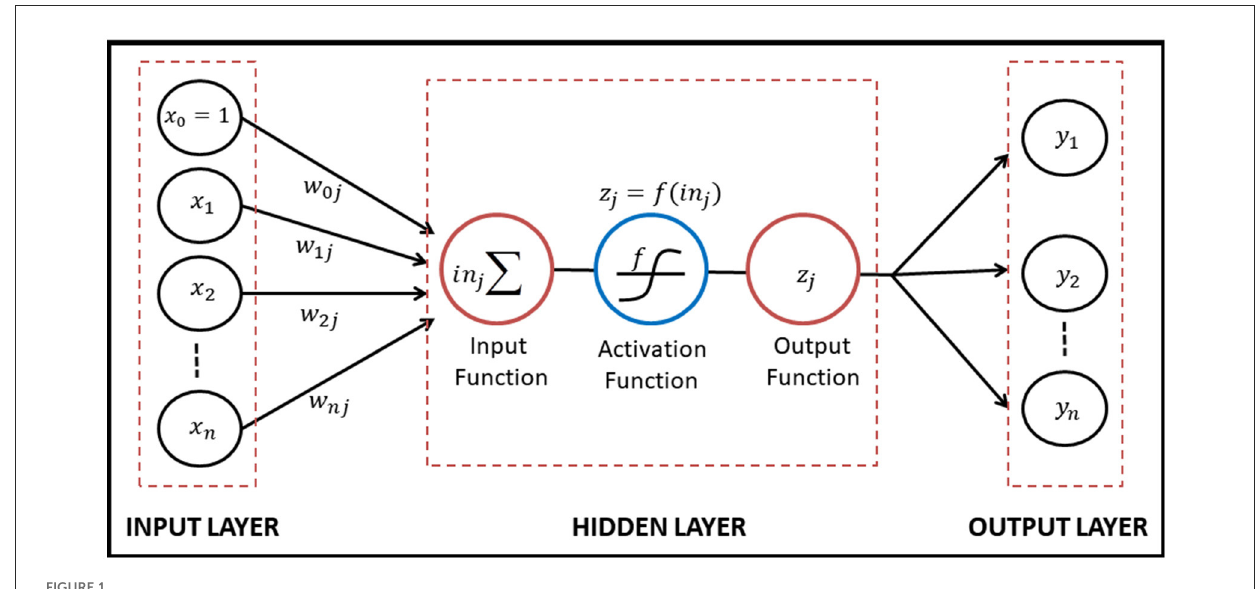
FIGURE1 A construction of mathematical neuron